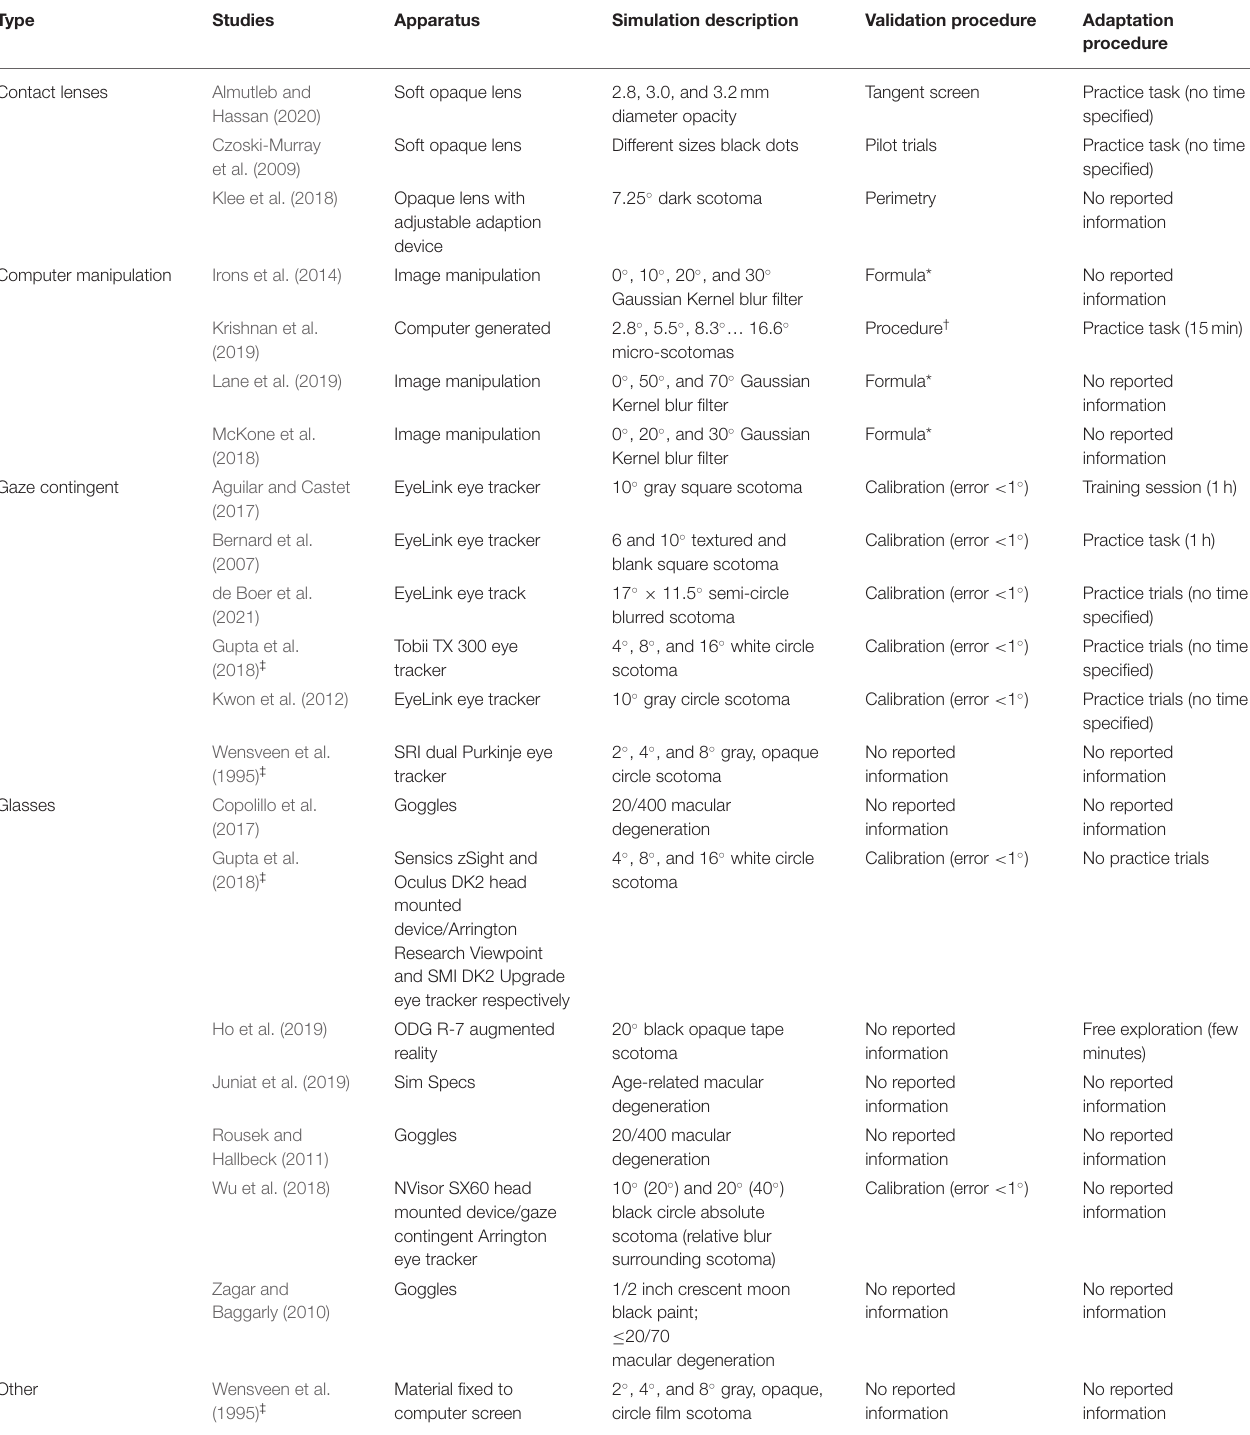
TABLE 2 | Age-related macular degeneration simulation